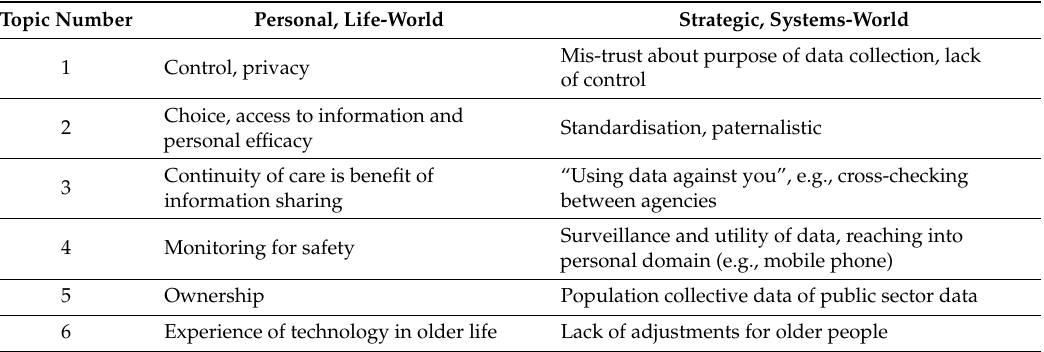
Table 3. Topics which emerged during